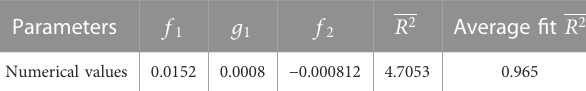
TABLE 4 Fitting parameters of exponential function type II.